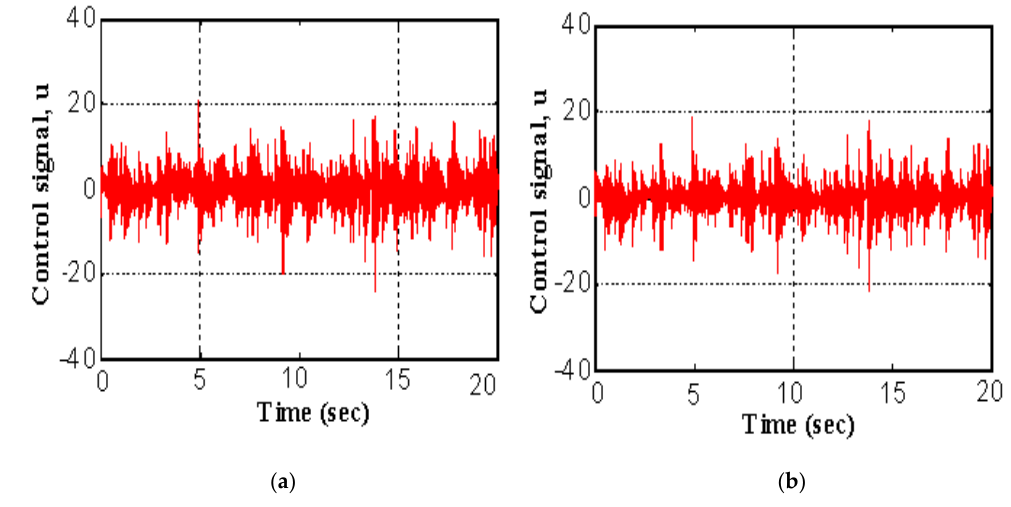
Figure 6. Control signals with measurement noise: ( a ) C-ADRC, ( b ) N-ADRC.